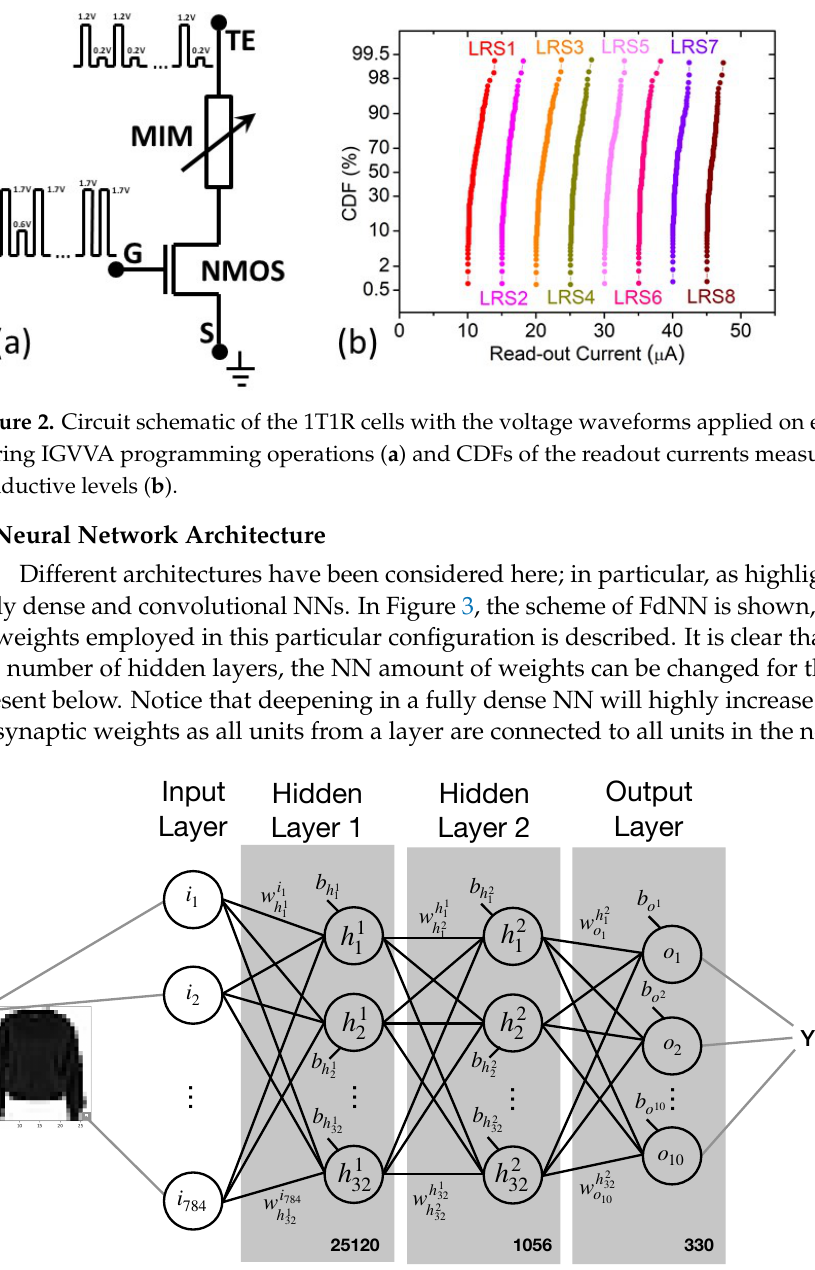
Figure 3. Fully dense neural network. The number of synaptic weights in this example NN is 26,506. The dataset (Fashion MNIST) was employed here. It uses images of size 28 × 28 as input; therefore, there are 784 neurons in the first layer. Later on, a first hidden layer of 32 neurons receives those 784 weights plus a bias term each (784 × 32 + 32 = 25,120), a second hidden layer of 32 neurons receives 32 weights of previous layer plus a bias term each (32 × 32 + 32 = 1056) and finally an output layer of 10 neurons receives 32 weights of the last hidden layer plus a bias term each